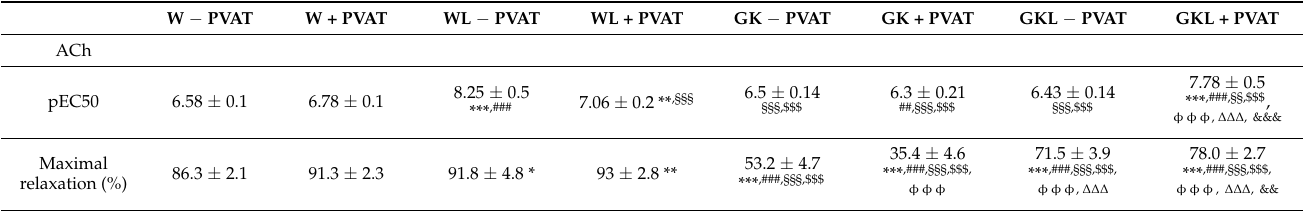
Table 2. Maximal relaxation responses (%) and − logEC50 in isolated aorta arteries of diabetic Goto-Kakizaki (GK) rats and age-matched nondiabetic Wistar rats with or without perivascular adipose tissue (PVAT). W and GK rats treated with luteolin (WL, GKL) with (+PVAT) or without ( − PVAT) perivascular adipose tissue. pEC50 values are presented as the negative logarithm ( − logEC50) of concentration of the